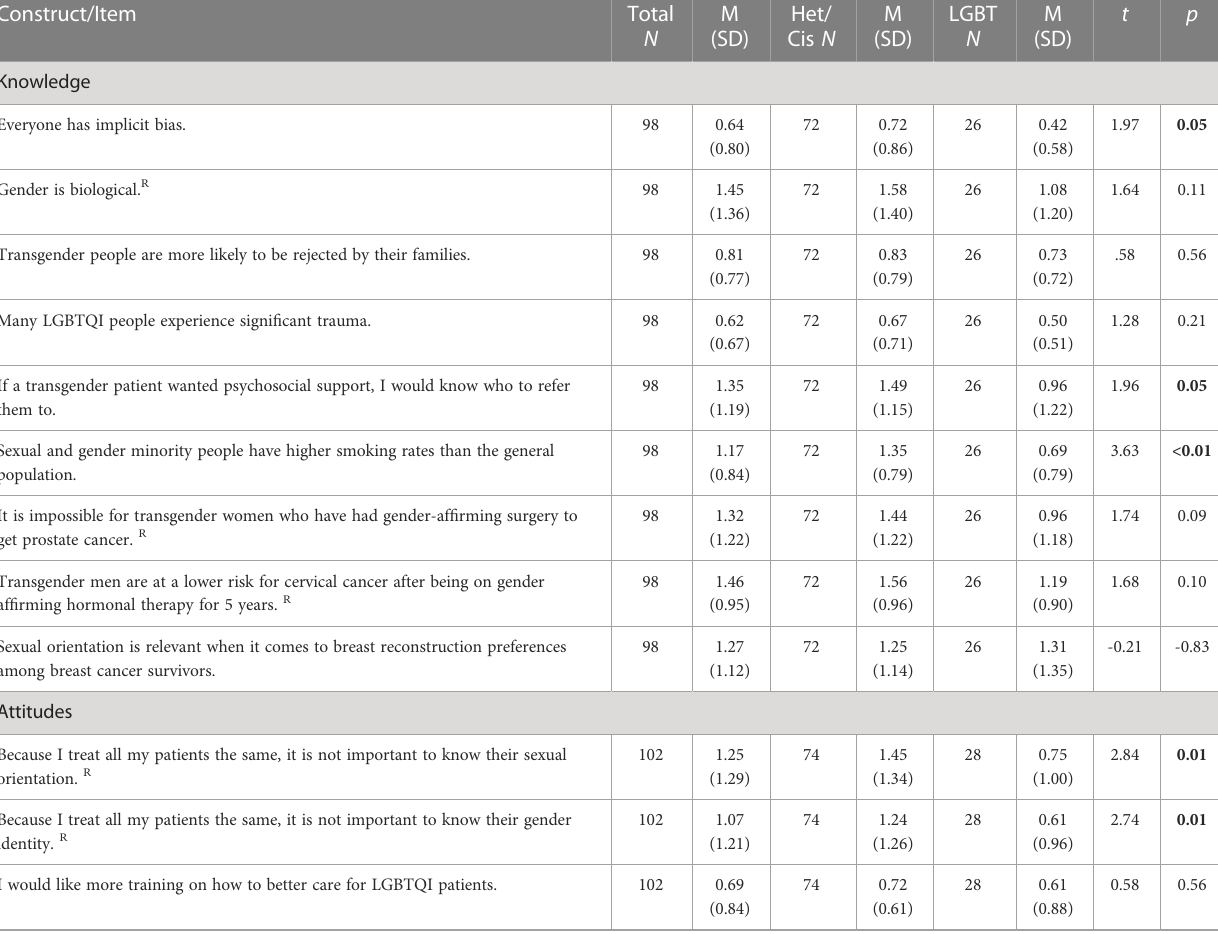
TABLE 5 Provider ’ s knowledge, attitudes, and clinical preparedness in caring for LGBTQI